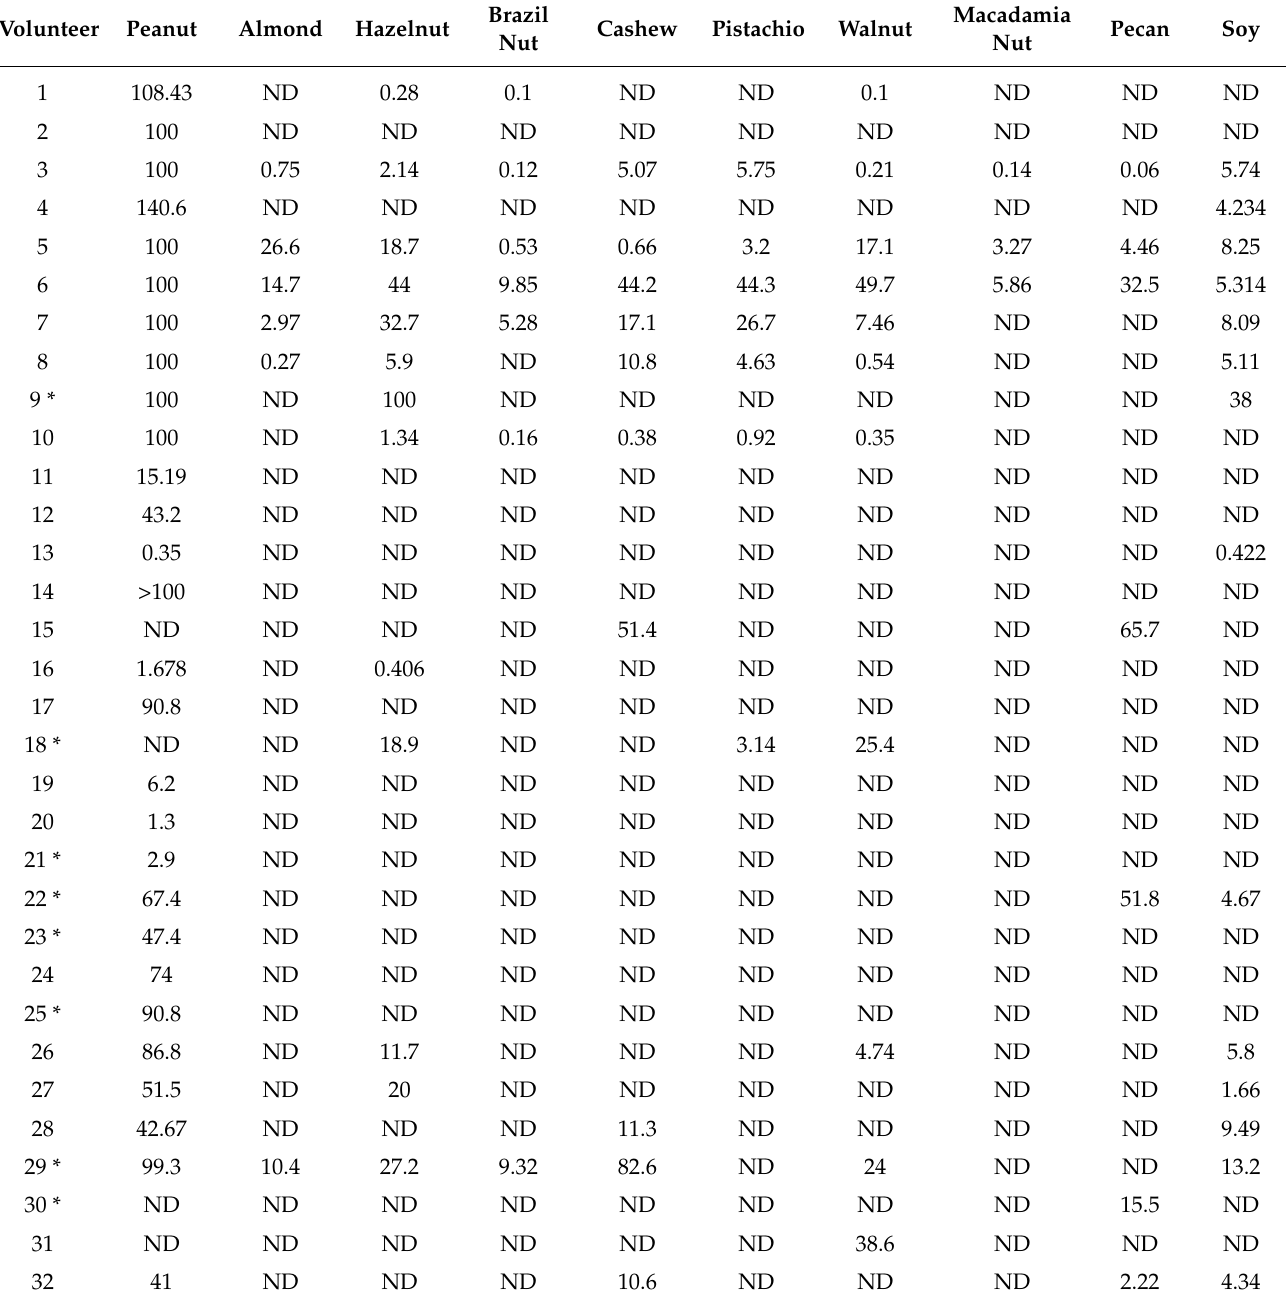
Table 1. ImmunoCAP Values for Peanut and Tree Nut Allergic